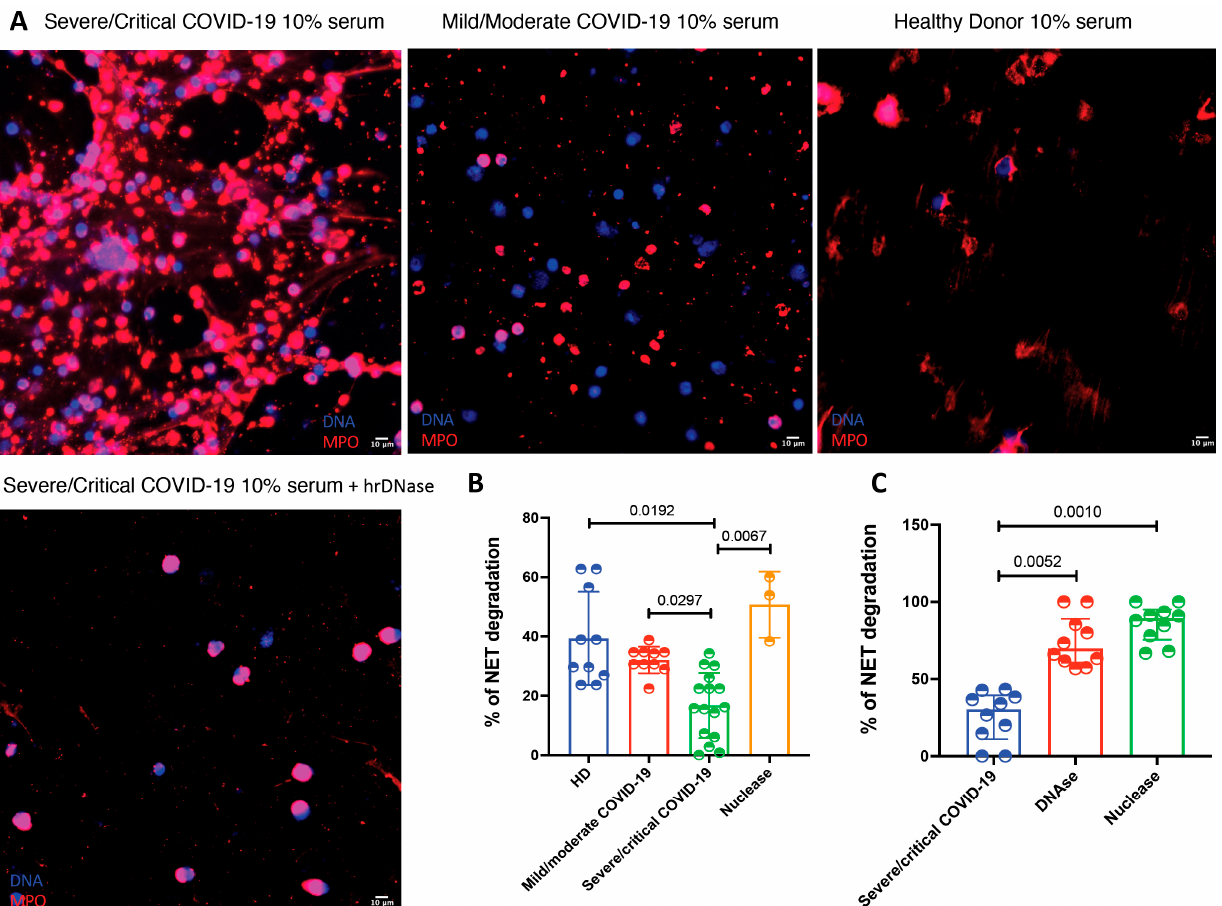
Figure 4. The sera from patients with severe and critical COVID-19 have a deficient NET degrading capacity. ( A ). Representative confocal microscopy images of the NET degradation capacity of COVID-19 sera according to disease severity. Neutrophils from healthy donors (HD) were stimulated with PMA to induced NET formation and then incubated with 10% sera from COVID19 patients or HD. The deficient degradation capacity is corrected after the addition of human recombinant DNAse. B-C. Severe/critical COVID-19 patients ( n = 16) have a deficient degradation of NETs in comparison to mild/moderate COVID-19 ( n = 8) and healthy donors ( n = 10) ( B ). The serum deficient degradation capacity of NETs observed in severe/critical COVID-19 patients ( n = 16) is reverted after the addition of hrDNase and micrococcal nuclease ( C ). Medians were compared using the Kruskal–Wallis test and Dunn’s multiple comparison test.